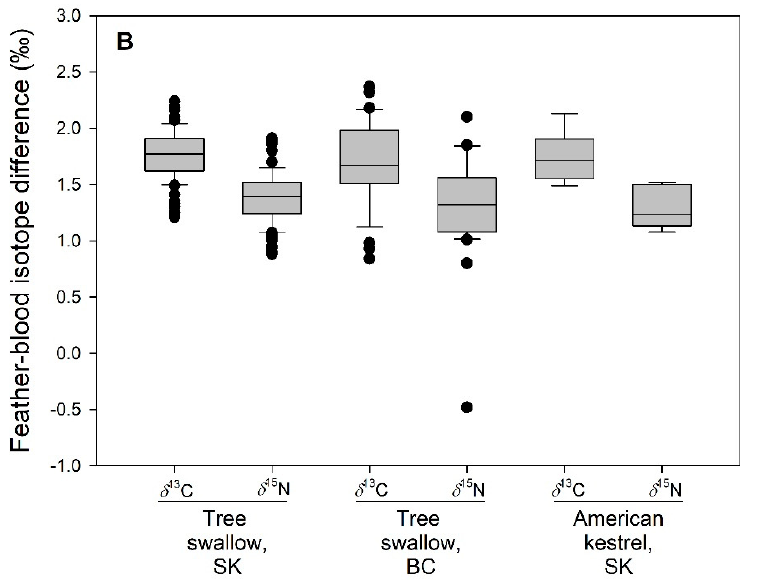
Figure 3. Blood-feather differences (‰) for δ 2 H ( A ) and δ 13 C and δ 15 N ( B ) in wild tree swallows from British Columbia (BC) and Saskatchewan (SK), nesting in plywood and aspen boxes; wild American kestrels nesting in plywood boxes in boreal forest, SK, and female mallard ducklings raised in captivity ( δ 2 H difference only). Differences may be slightly smaller for δ 2 H in swallows but not kestrels due to inclusion of blood lipids (see Table 2), 2008; n = 16 and 14, respectively, for 36- and 51-day-old mallard duckling age groups. Boxplot shows median (horizontal line), 25% and 75% values (lower and upper edges of shaded box), 5% and 95% values (horizontal whiskers), and extreme values (filled circles).